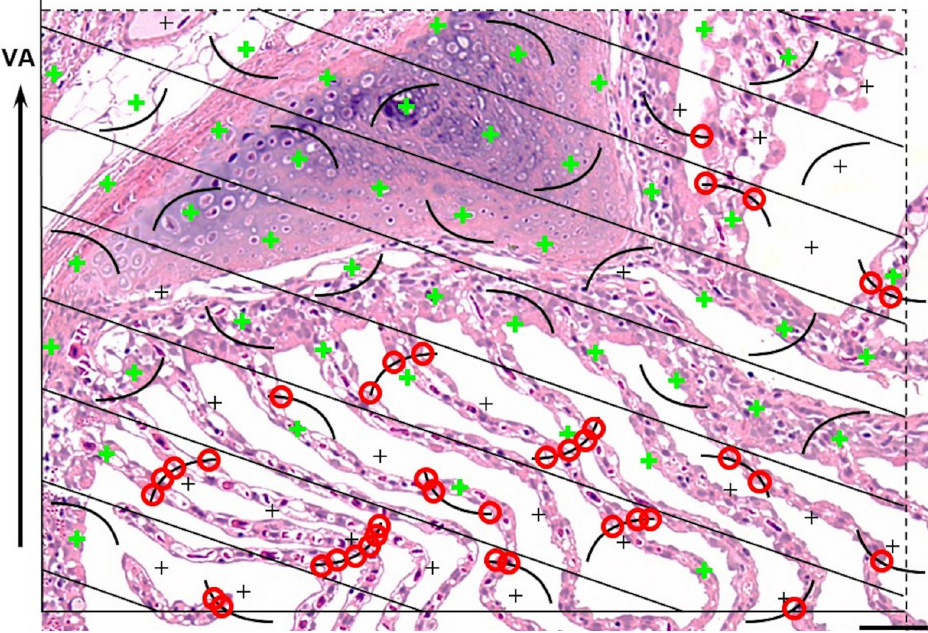
Fig 13. Estimation of the surface area density of the secondary lamellae in the gill filaments. A SUR sampled microscopic test field in a VUR section of a GMA/MMA-embedded (SUR sampled) GF sample is superimposed with a stereological test system combining 35 cycloids and 70 points. The short side of the rectangular frame of the system and therewith the minor axis of the cycloids is aligned parallel to the orientation of the vertical axis of the VUR GF section (VA, indicated by the arrow on the left). All points hitting GF section profiles (P (GF) , indicated in green) are counted, as well as all intersections of cycloids with the epithelial surface of SL section profiles (I (SL) , encircled in red). The SL surface area density in the GF is calculated from the sum of intersections ( ∑ I (SL) ) and points ( ∑ P (GF) ), counted in all examined test fields of all sections of all samples per case, using Eq 6 . In the presented example, the length of one cycloid (l) = 1/10 of the frame width [62], the test curve length in general is calculated from cycloid arch height h as: l = 2 x h [104]. GMA/MMA. HE. Bar = 50 μ